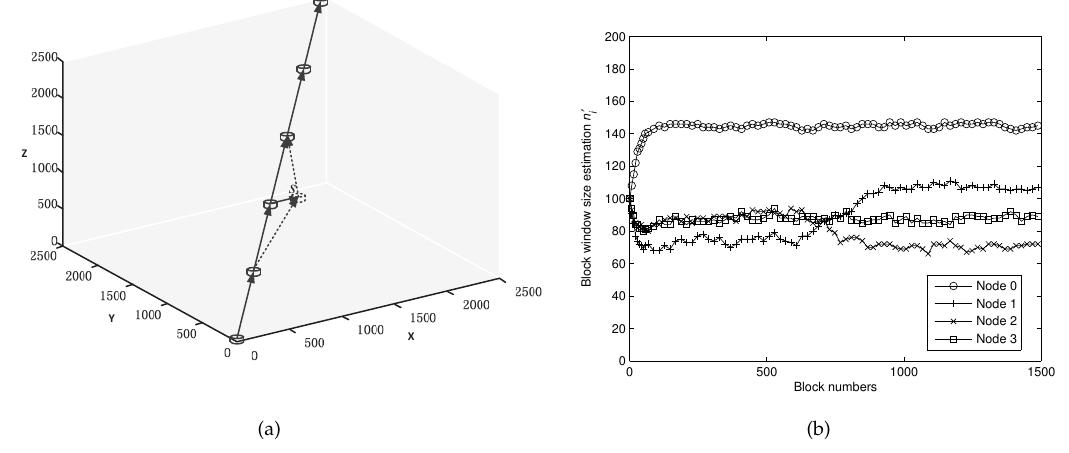
Figure 6. ( a ) an illustration for movement path; ( b ) the convergence procedure of estimating the block window size for moving